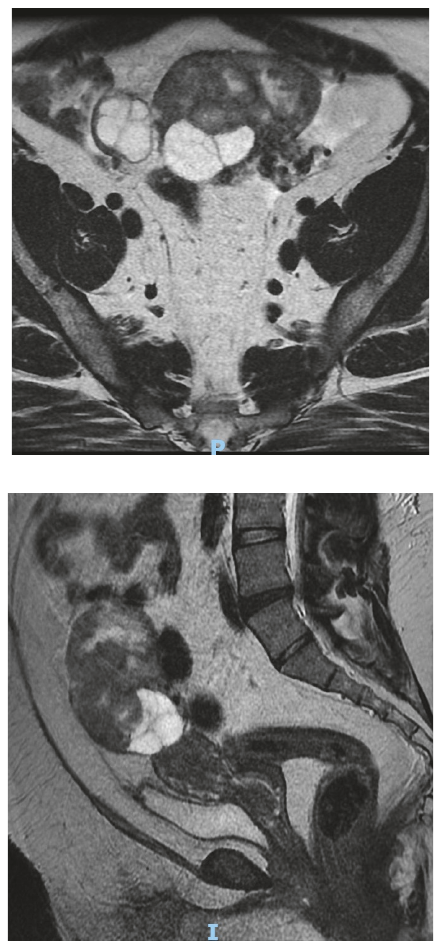
Figure 2: MRI abdomen and pelvis showed the presence of a large heterogeneous predominantly solid mass arising from the left ovary with cystic areas within. The solid components showed restricted diffusion and avid contrast enhancement. The mass was measured 8.4x6.1x8.9cm.Thesolidcomponentswerehyperintensetomuscle on T2w imaging and iso/hypointense on T1w